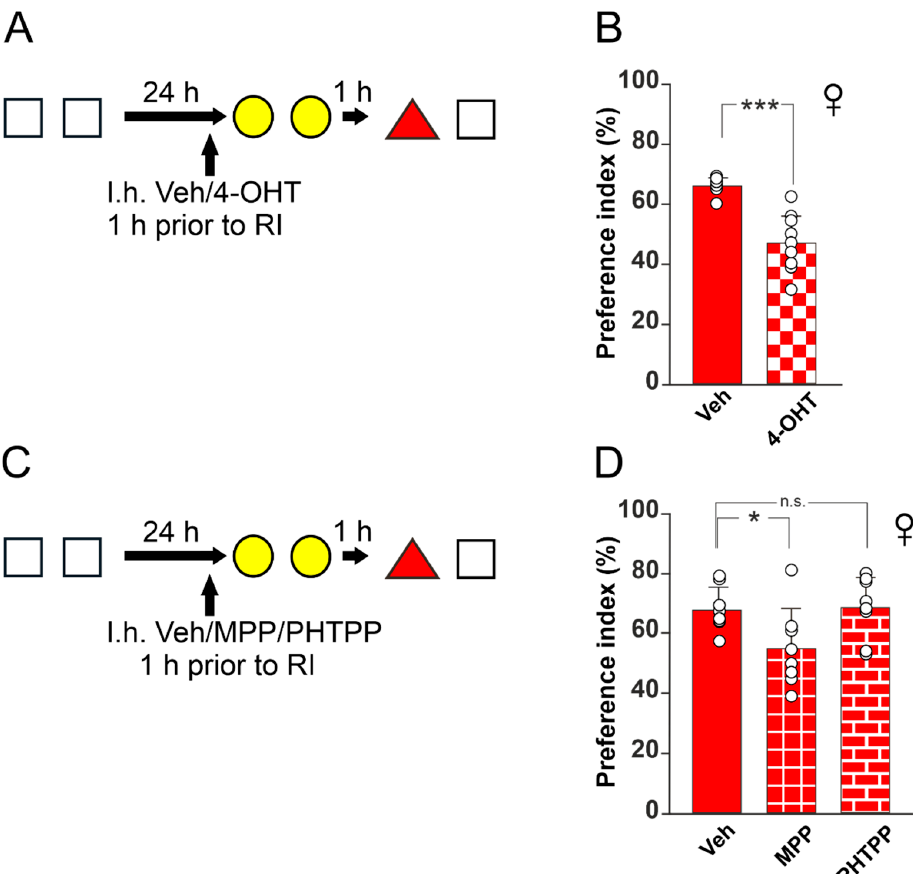
Figure 2. Estrogen receptors play a key role in resistance to retroactive interference. ( A ): Schematic representation of 4-hydroxytamoxifen (4-OHT) or vehicle (Veh) intrahippocampal (I.h.) injection during RI procedure; white squares represent object 1, yellow circles represent object 2, and red triangle represents object 3. ( B ): Histograms (means ± SD) showing preference indexes of animals undergoing RI after 4-OHT treatment. Note that 4-OHT injection induces memory loss. Asterisks indicate statistically significant differences between groups assessed by Kruskal–Wallis one-way